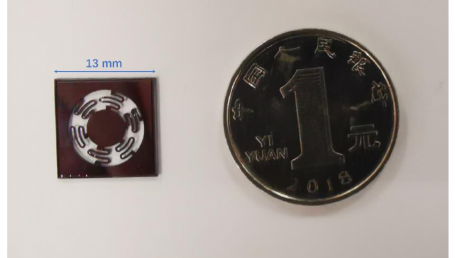
Figure 8. Photograph of the fabricated MEMS sensing chip.